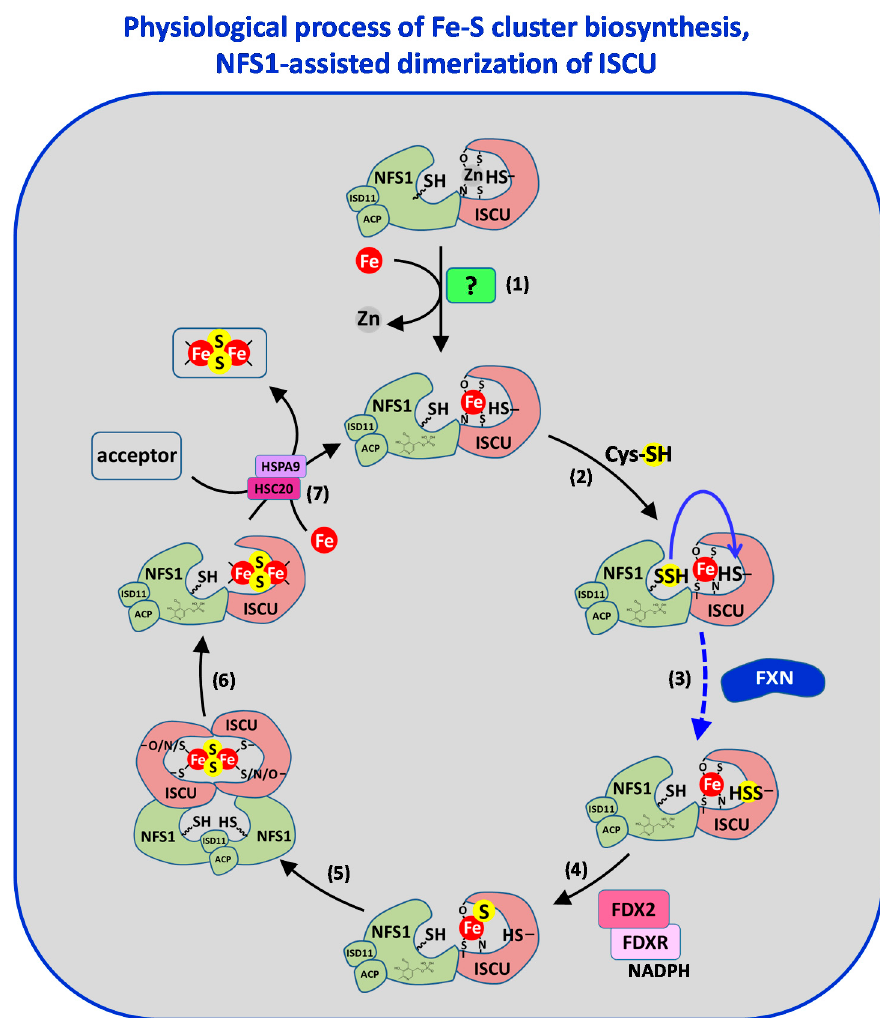
Figure 9. Model of FDX2-based Fe–S cluster biosynthesis by the eukaryotic ISC machinery relying on NFS1-assisted dimerization of ISCU. The reaction is initiated by insertion of iron in apo-ISCU, which may require a still ill-defined metallochaperone to remove the zinc ion ( 1 ). In the complex formed with NFS1–ISD11–ACP, a persulfide is formed on NFS1 ( 2 ) and transferred to ISCU ( 3 ). The persulfide of ISCU is reduced by FDX2, possibly into a mononuclear iron–sulfide intermediate ( 4 ). Then NFS1 in its open conformation enables the dimerization of ISCU, which leads to formation of a bridged [2Fe2S] cluster in ISCU ( 5 ). The bridged [2Fe2S] cluster segregates on one subunit ( 6 ) and is transferred to client proteins by the HSC20/HSPA9 chaperone system while a ferrous iron is inserted into apo-ISCU ( 7 ). FXN stimulates the whole reaction by accelerating persulfide transfer to ISCU ( 3 ). The solid blue arrow describes sulfur transfer to ISCU and the dashed blue arrow refers to the rate-limiting step that is accelerated by FXN.